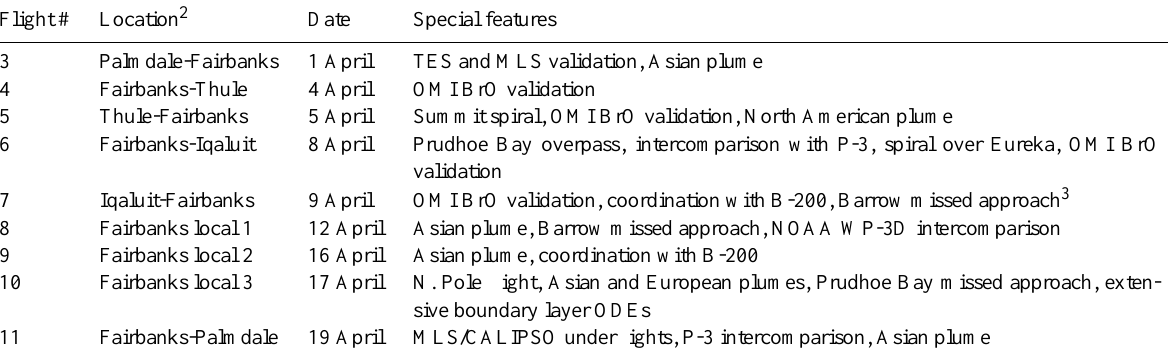
Table 4a. DC-8 flights during the ARCTAS-A spring deployment 1 .